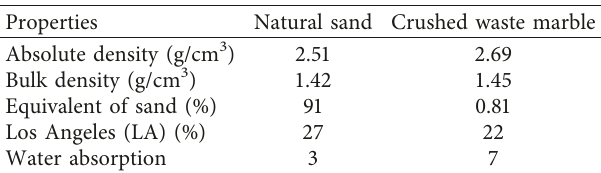
Figure 1: Particle-size distribution curve of SWM and natural sand. Table 2: Physical properties of natural sand and crushed waste